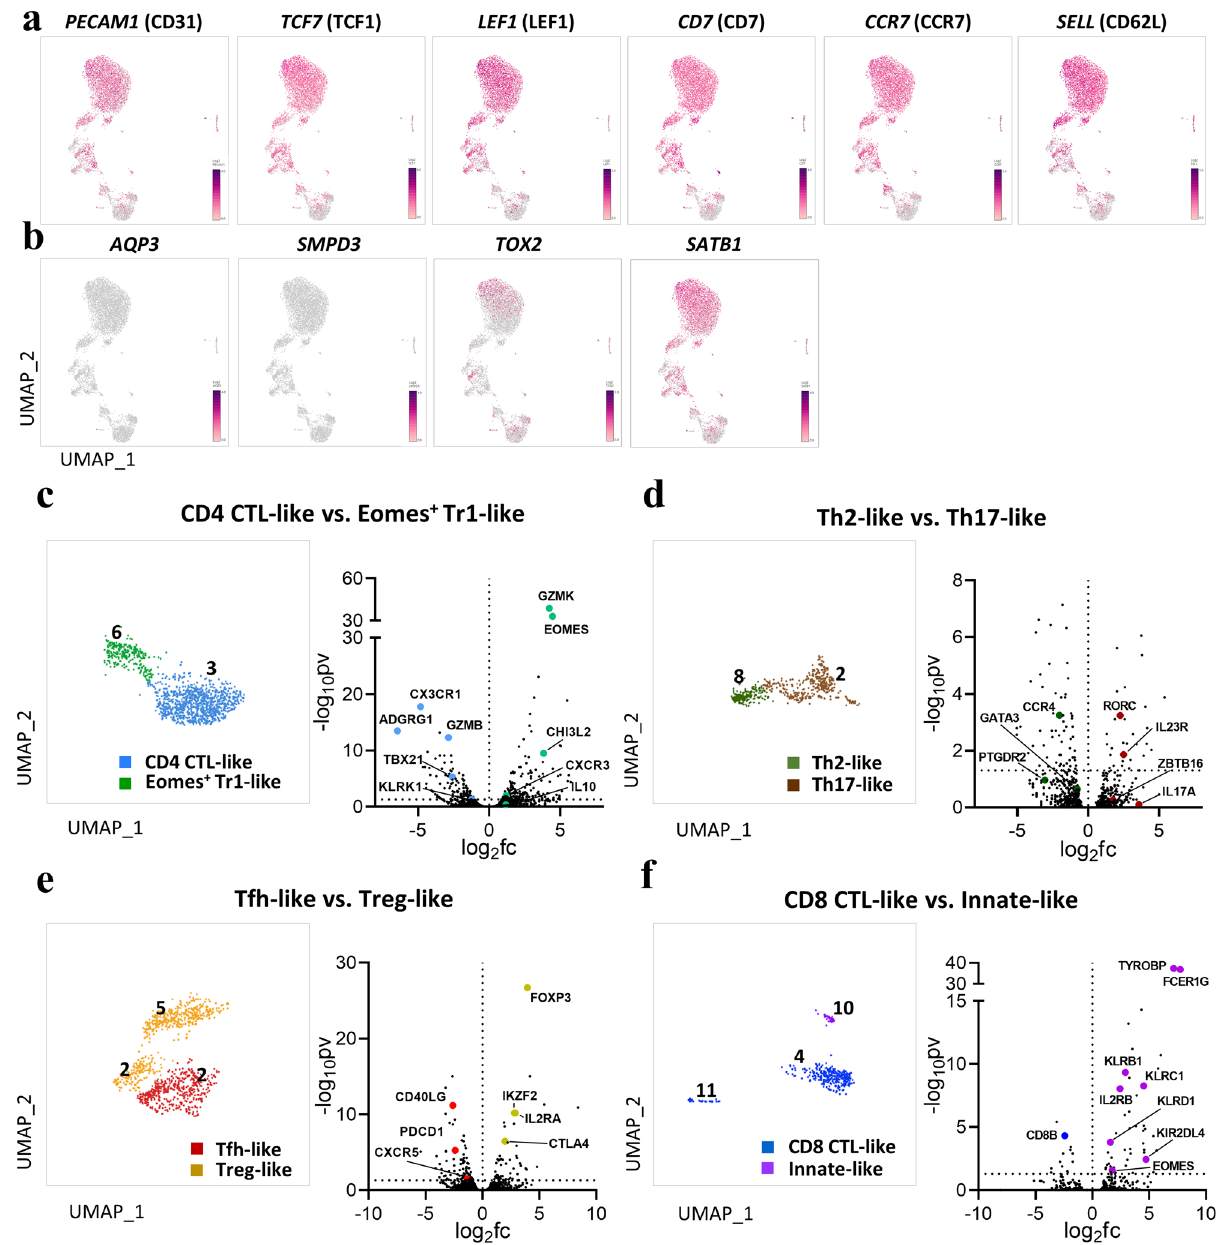
genes associated with thymic development. AQP3 and SMPD3 are expressed at the immature DP stage, and TOX2 and SATB1 are expressed during DP-to-SP transition. ( c – f ) Identification of marker gene signatures for the eight defined clusters. UMAP of paired clusters and volcano plot showing the log (fold change) and − log ( p -values) for pairwise differential expression between two DP T populations. ( c ) CD4 CTL-like vs . Eomes + Tr1- like cells. ( d ) Th2-like vs. Th17-like cells. ( e ) Tfh-like vs. Treg-like cells. ( f ) CD8 CTL-like vs . Innate-like cells. All plots were generated using GraphPad Prism 8.0.2. The dotted horizontal line represents a p -value of 0.05. The number in UMAP indicates the cluster